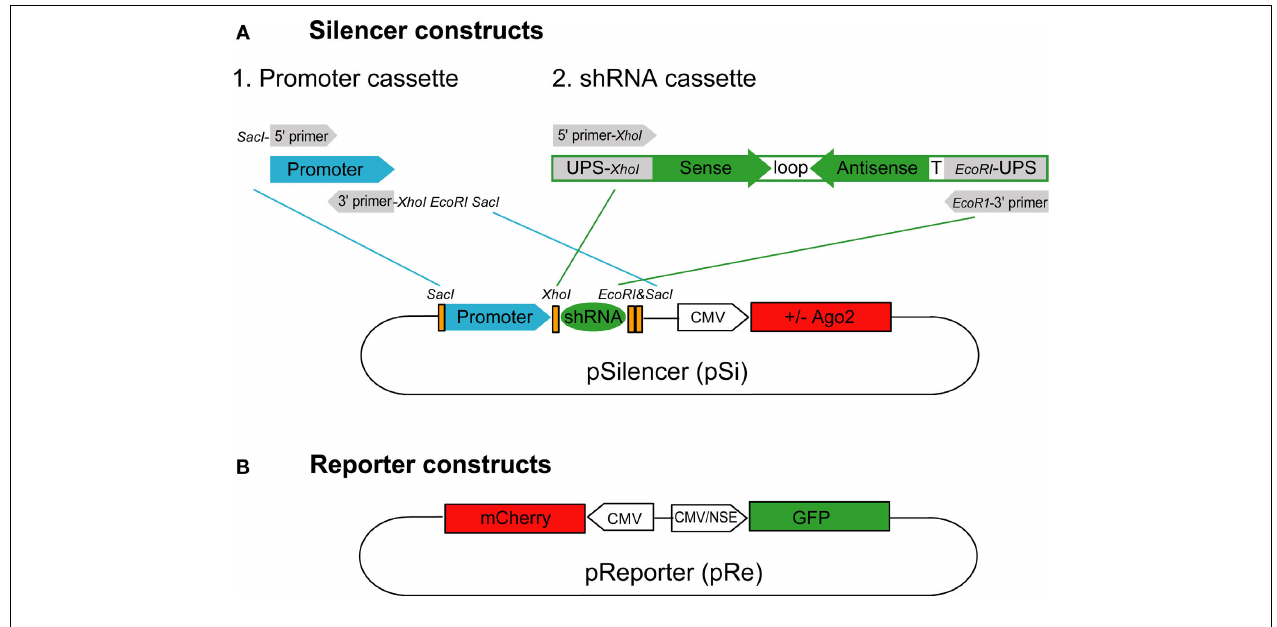
FIGURE 1 | Silencer and reporter constructs used to test RNAi effi cacy. (A) The silencer construct, pSi, includes two cassettes for easy exchange of promoters and shRNAs with or without Ago2 co-expression. The shRNA promoter fragments can be inserted into pSi through the Sac I site on the vector and the shRNA fragments can then be inserted into pSi at Xho I